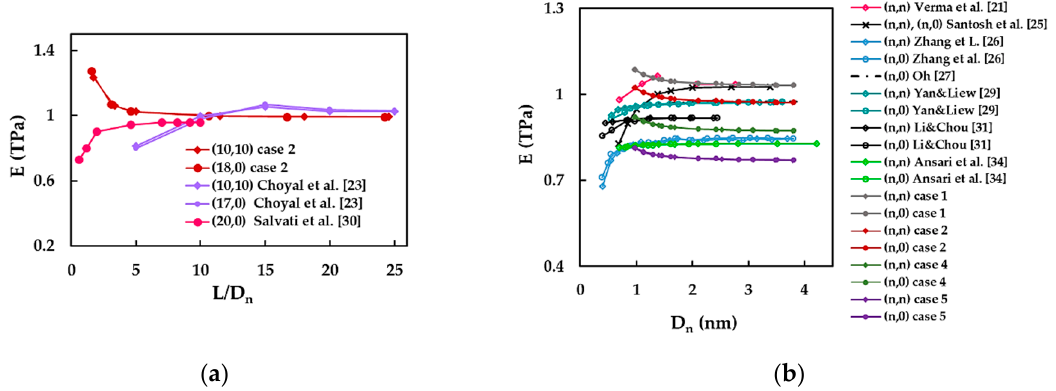
Figure 13. A comparison of the current results of Young’s modulus of SWBNNTs with those reported in the literature as a function: ( a ) the nanotube aspect ratio, L/D n ; ( b ) the nanotube diameter, D n .